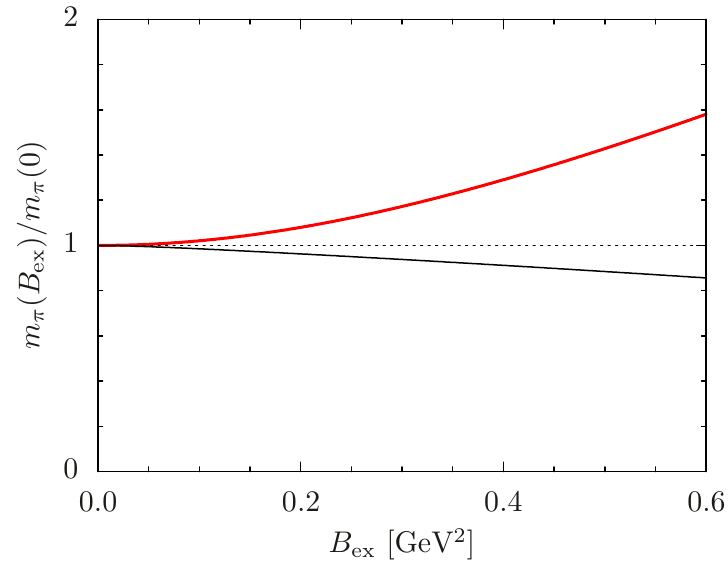
Figure 4 . Dependence of the neutral pion mass on the external magnetic (cid:12)eld in units of the vacuum pion mass. Thick red line: the tree-level anomalous mass, given by eq. (3.6). Thin black line: the non-anomalous, one-loop mass according to refs. [20, 21]. The dashed black line is added just to guide the eye. The numerical results were obtained using the physical values f (cid:25) (cid:25) 92 MeV and m (cid:25) (cid:25) 135 MeV; the anomaly contribution dominates over the non-anomalous loop correction for B ex & 0 : 1 GeV 2 . The upper end of the displayed range for B ex corresponds to 10 20 G.